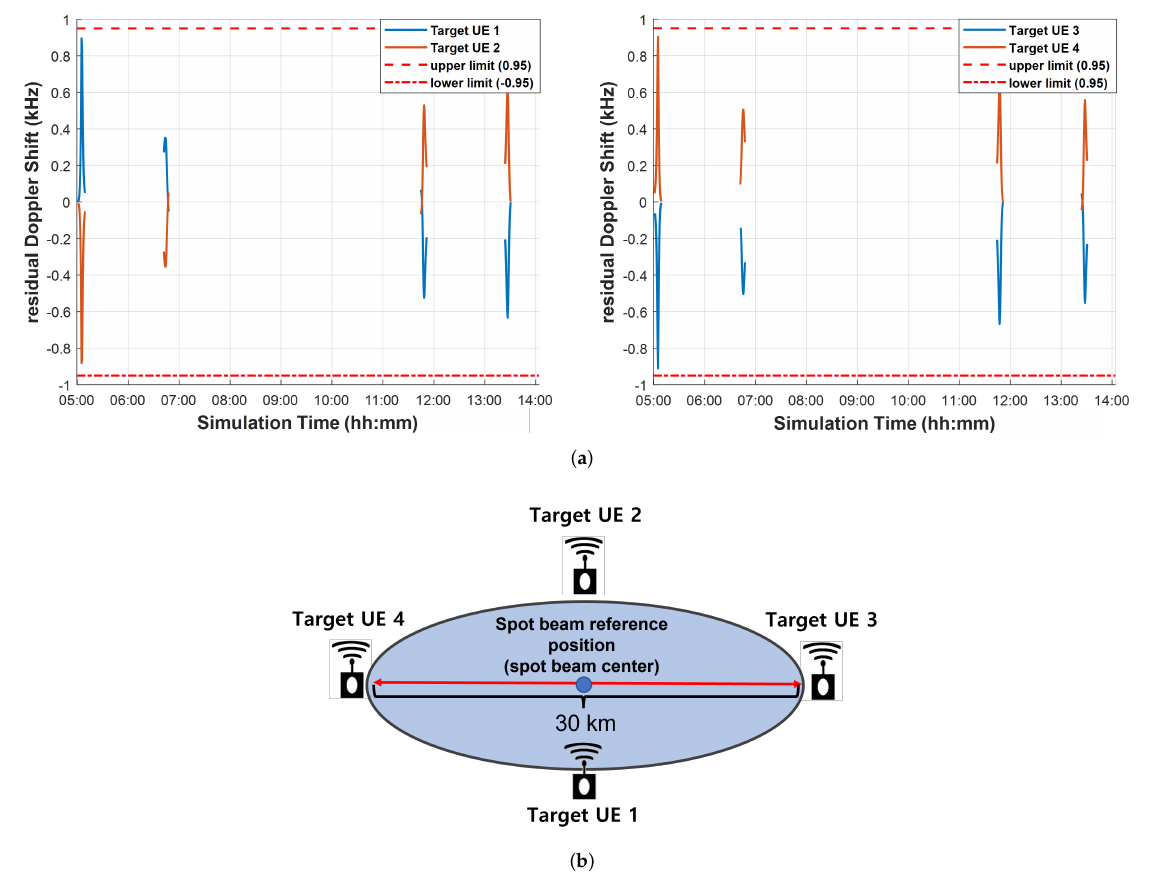
Figure 9. Doppler shift and maximum coverage size compensable by NB − IoT receivers. ( a ) Residual Doppler shift, ( b ) Target